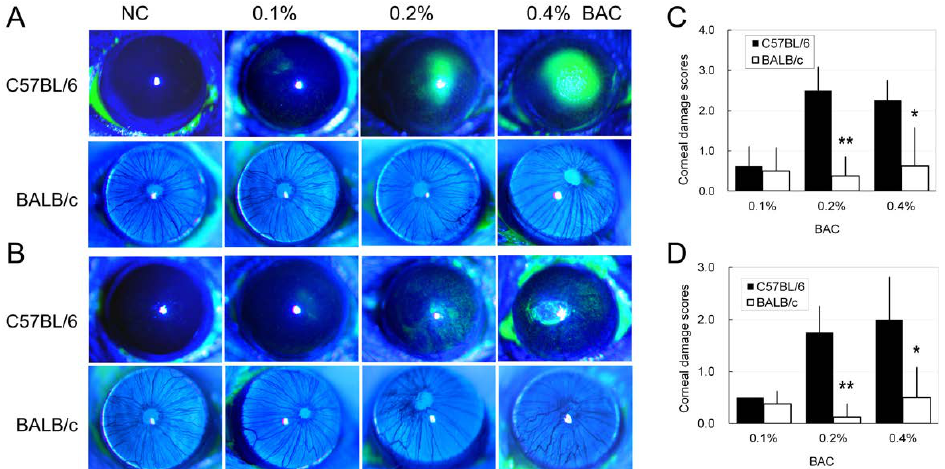
Figure 3. Epithelial disruption in the corneas of C57BL/6 and BALB/c mice induced by